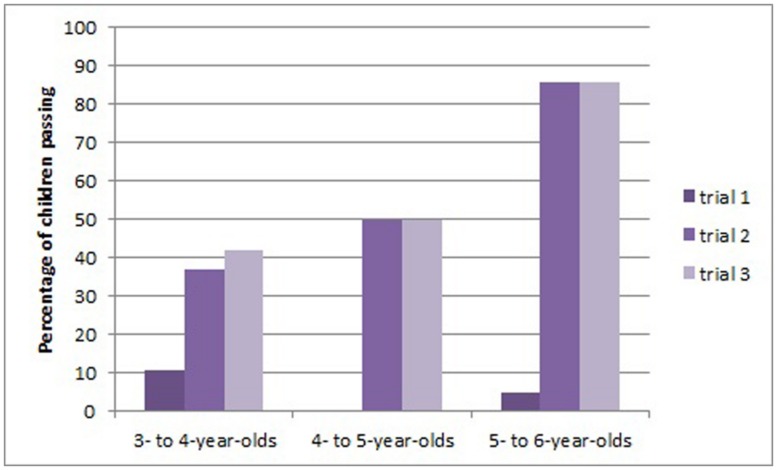
Performance on each trial before demonstration in Study 2, reduced sample of children who had made a hook or seen a demonstration of hook making.